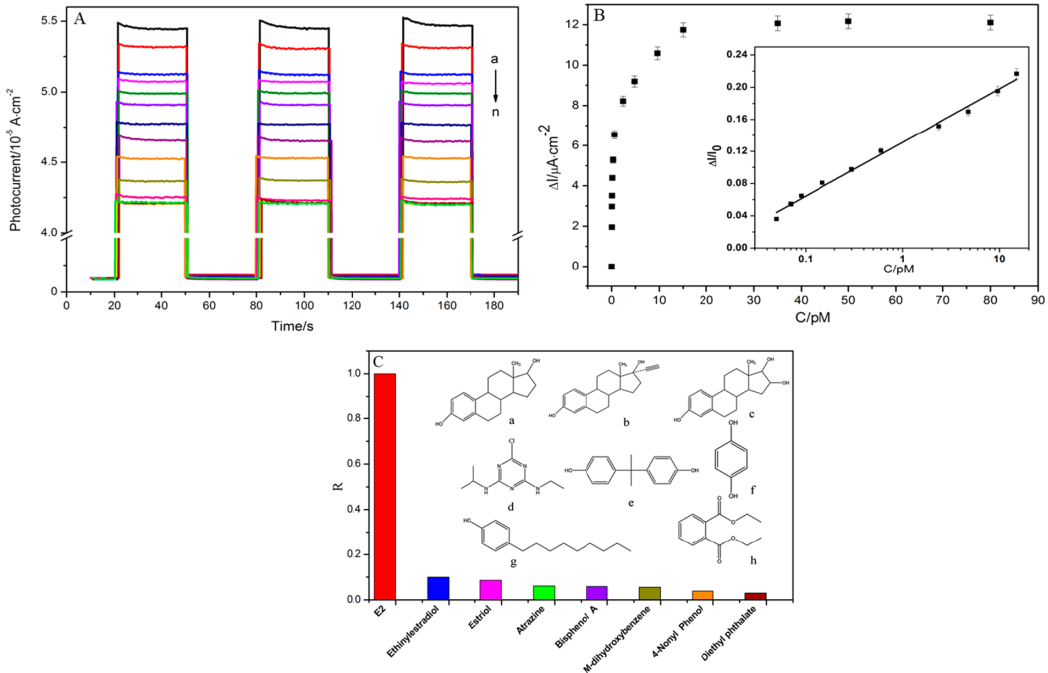
Figure 6. ( A ) photocurrent change of the aptasensor in different concentrations of 17β-estradiol from 0 (response a) to 80 pM (response n); ( B ) curve of ΔI corresponding to the concentration of 17β-estradiol from 0 to 80 pM (ΔI was calculated by I 0 subtracting I, where I 0 and I are the photocurrent before and after incubation of 17β-estradiol). The inset is the linear relationship between ΔI/I 0 and the logarithm of 17β-estradiol concentrations from 0.05 to 15 pM; and ( C ) selectivity of the assay for 17β-estradiol on the aptasensor. The inset are the structural formulas of 17β-estradiol and the tested interferents (Reprinted with permission from Fan et al. [70]. Copyright (2014) American Chemical Society).